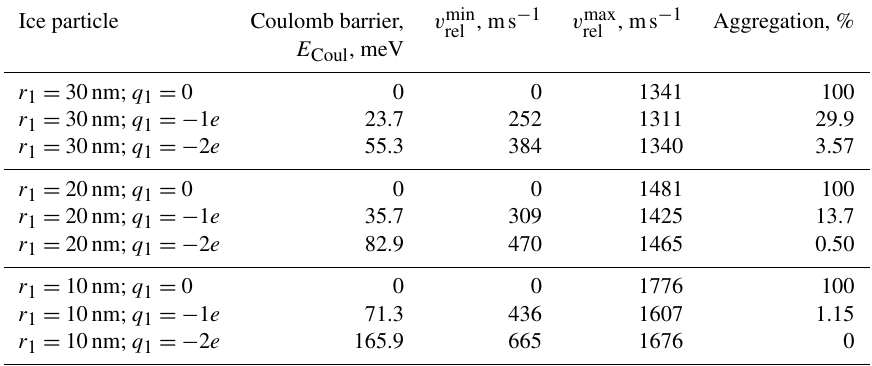
Table A2. Energetic considerations and the percentage of aggregation for MgO–ice collisions at T = 150K and k r = 0 . 9 (the surface point charge model). The MgO particle has the fixed radius and charge ( r 2 = 0 . 2nm, q 2 = − 1 e ), and the size and charge of ice particle is varied. The collision geometry is shown in Fig.